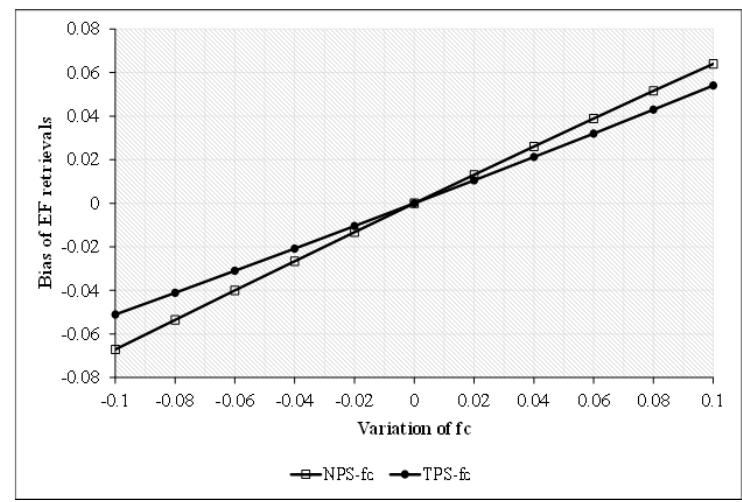
Figure 14. Sensitivity of EF retrievals to the variation of f c .